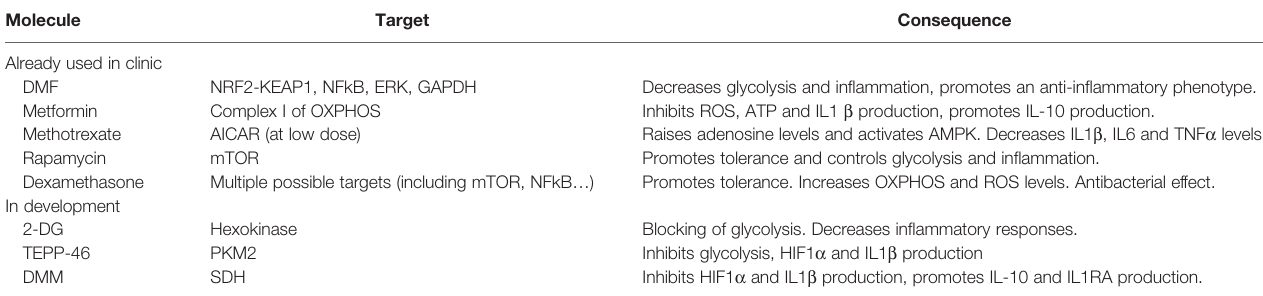
TABLE 2 | Potential therapeutic molecules for the treatment of infections. Molecule